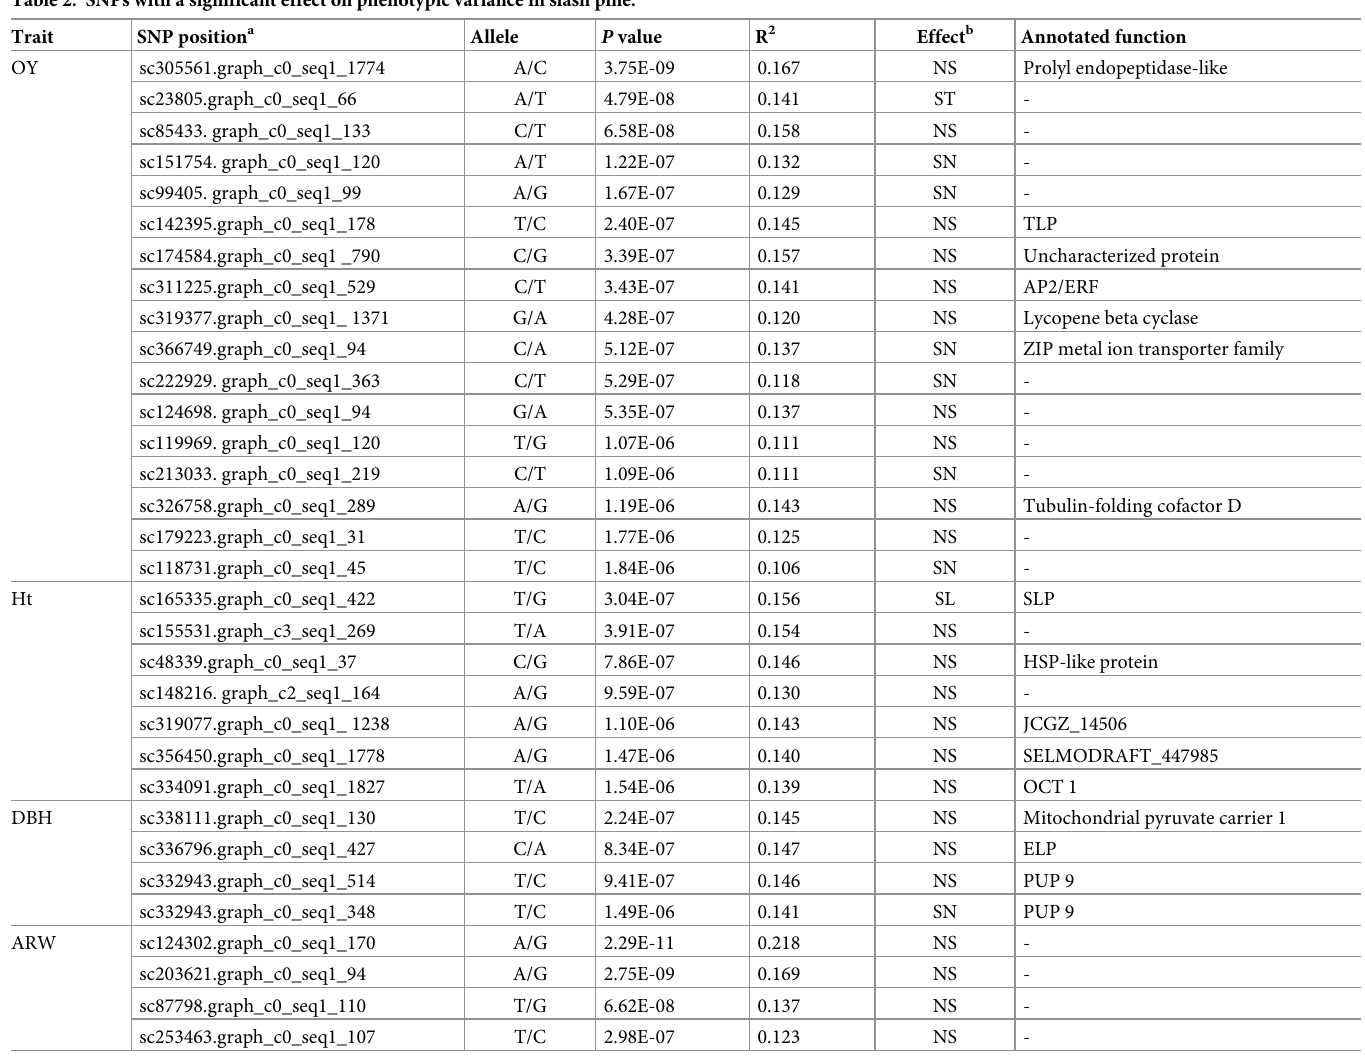
Table 2. SNPs with a significant effect on phenotypic variance in slash pine. Trait SNP position a